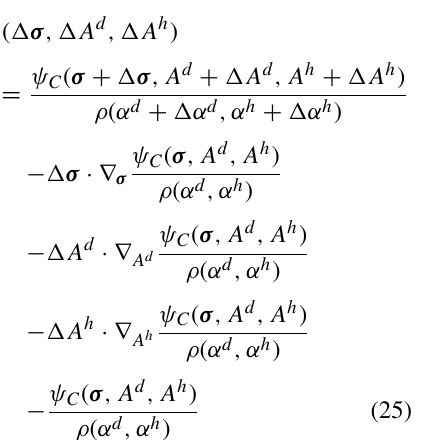
F.V. Tormena et al. / A bone remodelling model based on generalised thermodynamic